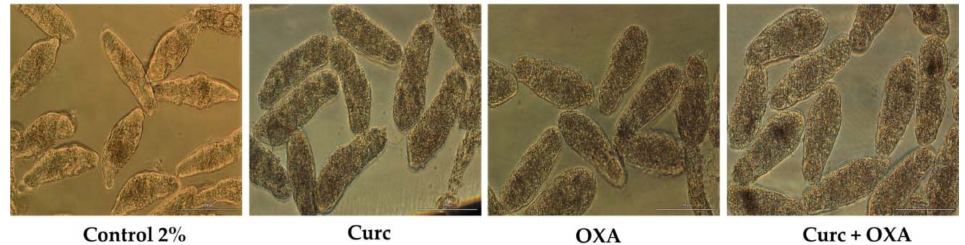
Figure 8. Representative micrographs of NTS at 72 h of exposure to Curc and OXA and combined, at 25 µ M and 1:1 constant ratio; × 20; bright field; scale bar, 100 µ